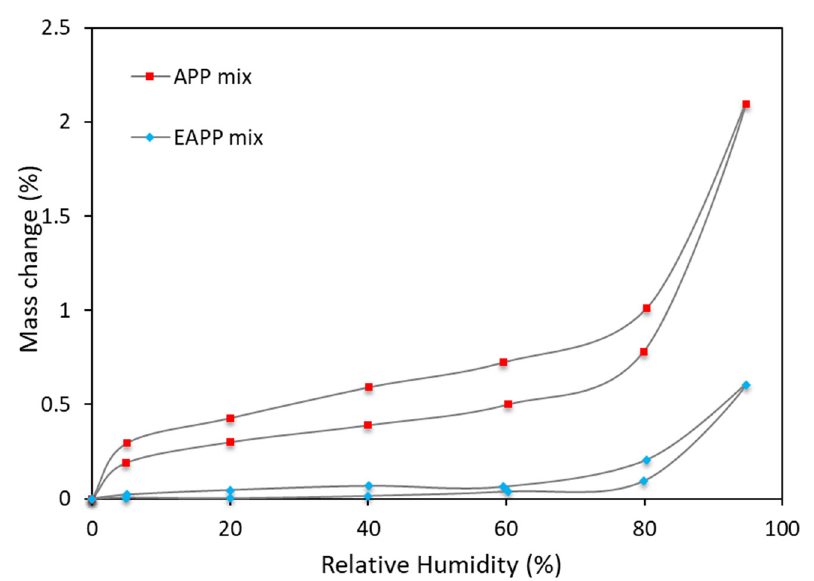
Figure 3. Vapor sorption isotherms of the intumescent blends.